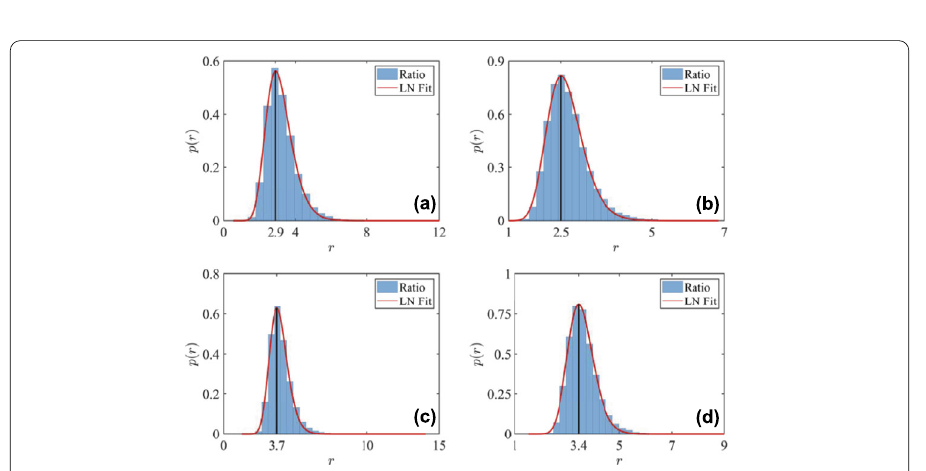
Figure 8 Empirical distribution of the scale ratios for the egos with different layers based on different cluster algorithms for the SVEIN. ( a ) Three layers and k -means algorithm. ( b ) Four layers and k -means algorithm. ( c ) Five layers and H / T break algorithm. ( d ) Six layers and H / T break algorithm